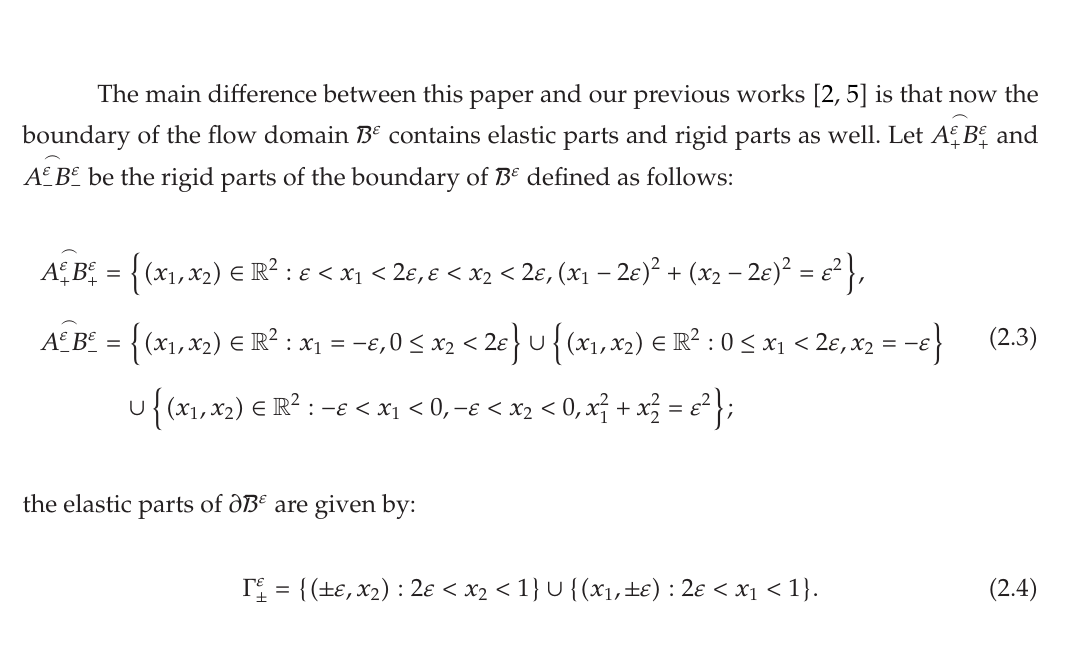
Figure 3: The domain B ε